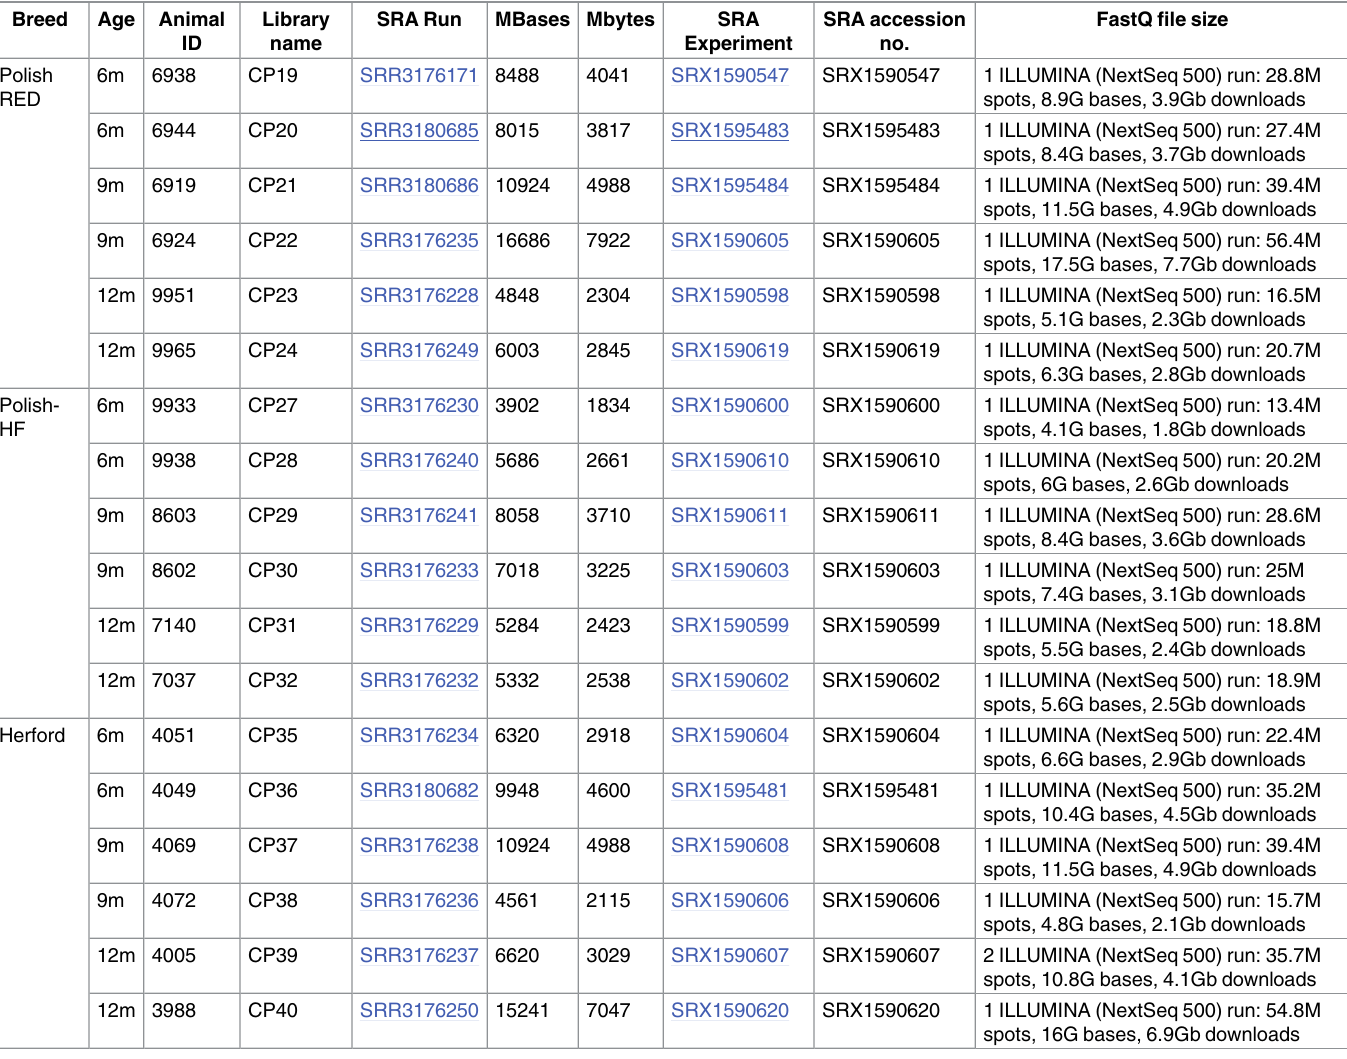
FastQ file size no.